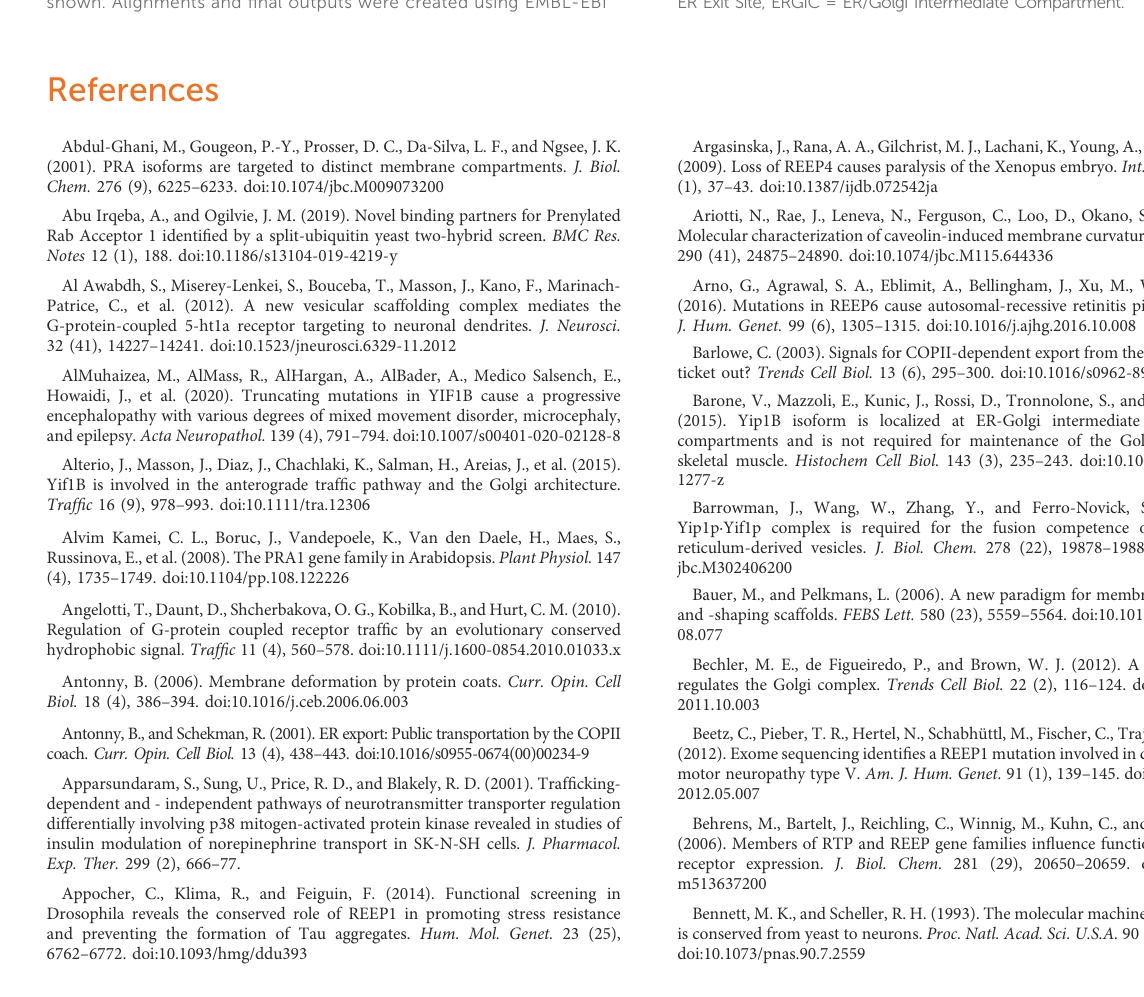
horizontal lines with the short vertical bar representing the distance (dissimilarity) between the two clusters. SUPPLEMENTARY FIGURE S2 Yipf Family Multiple Sequence Alignment. Amino acid alignment of Yipf1- 7. GenBank and HGNC namesand total amino acid number are listed on the left. Amino acid types are color coded by type of amino acid: Hydrophilic Basic — Red, Hydrophilic Acidic — Purple, Hydrophilic Uncharged Polar — Green, Hydrophobic Aromatic/Aliphatic — Blue. Conservation and consensus sequences are shown. Alignments and fi nal outputs were created using EMBL-EBI Multiple Sequence Alignment and Jalview (Waterhouse et al., 2009; Madeira et al., 2022). SUPPLEMENTARY FIGURE S3 AlphaFold Prediction of Membrane Topology for Yipf/REEP/Yif/PRAF Protein Families. Human Yipf1, REEP2, Yif1A and PRAF1 structures predicted by AlphaFold. For an interactive view, visit https://alphafold. ebi.ac.uk (Jumper et al., 2021; Varadi et al., 2022). Yipf1 https://alphafold. ebi.ac.uk/entry/Q9Y548. REEP2 https://alphafold.ebi.ac.uk/entry/ Q9BRK0. Yif1A https://alphafold.ebi.ac.uk/entry/O95070. PRAF1 https://alphafold.ebi.ac.uk/entry/Q9UI14. SUPPLEMENTARY FIGURE S4 REEP Family Multiple Sequence Alignment. Amino acid alignment of REEP1-6. GenBank and HGNC names and total amino acid number are listed on the left. Amino acid types are color coded by type of amino acid: Hydrophilic Basic — Red, Hydrophilic Acidic — Purple, Hydrophilic Uncharged Polar — Green, Hydrophobic Aromatic/ Aliphatic — Blue. Conservation and consensus sequences are shown. Alignments and fi nal outputs were created using EMBL-EBI